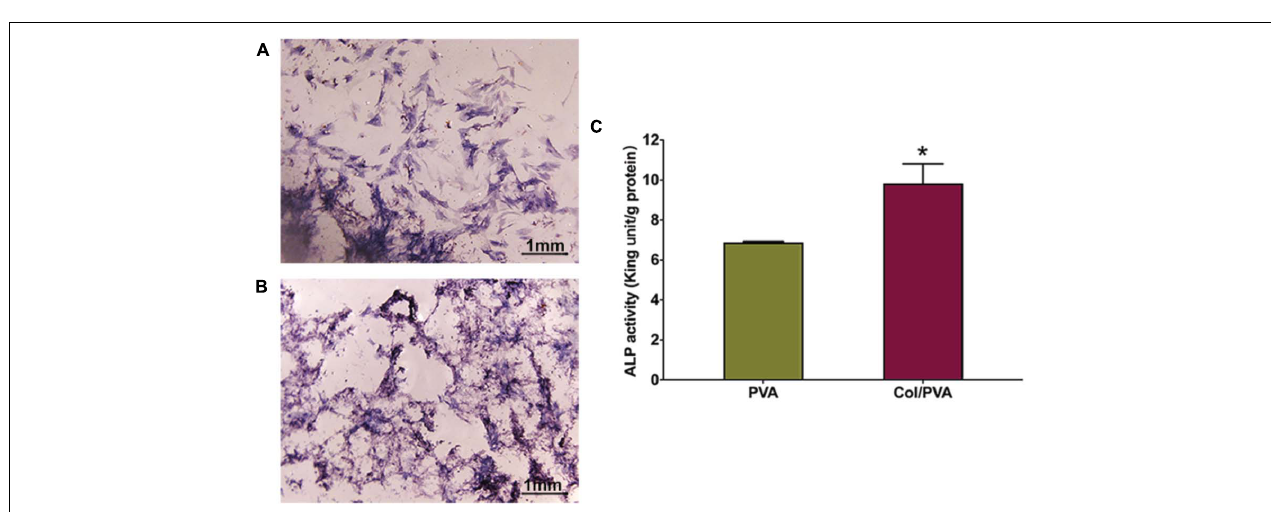
FIGURE 7 | Expression profile of osteogenic differentiation related genes (A) RUNX2, (B) ALP, (C) OCN, (D) COL1 of BMSCs cultured on the collagen layer of the Col/PVA dual-layer membrane and pure PVA membrane for 7 and 14 days. *indicates a significant difference between Col/PVA and PVA group with p -value < 0.05.